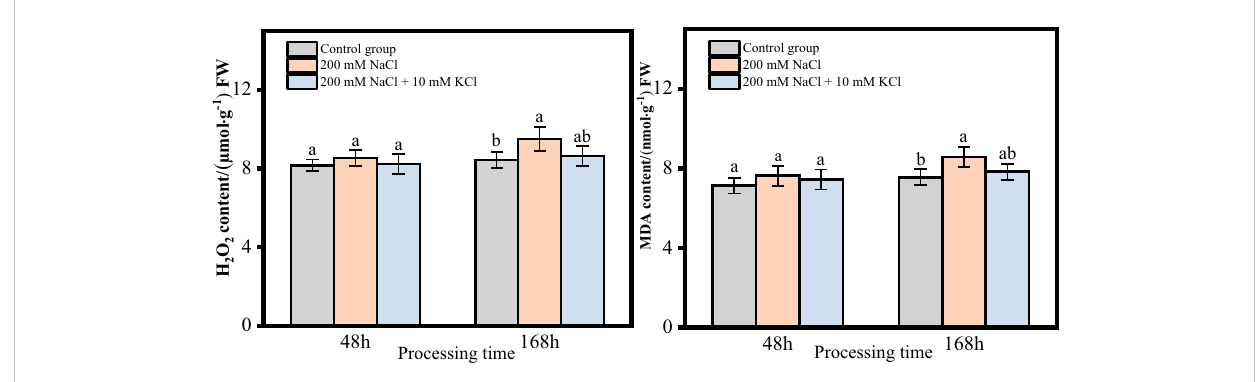
FIGURE 3 Change of H 2 O 2 and MDA content of T. ramosissima roots under NaCl stress with exogenous K + application (Changes of H 2 O 2 and MDA content in the roots of T. ramosissima at 48h and 168h in the control group and different treatment groups. Different letters indicate the signi fi cance of differences among treatments at the same time, p < 0.05).